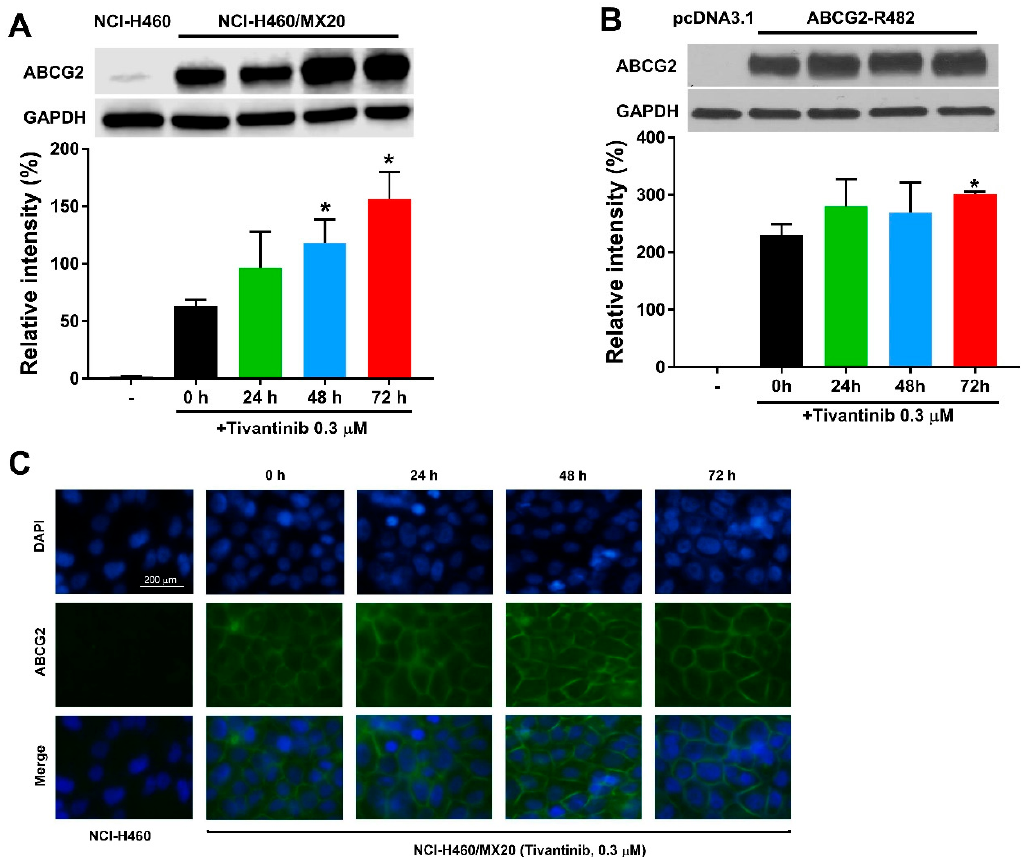
Figure 4. Tivantinib increases the protein expression in cells overexpressing ABCG2 without affecting the ability of ABCG2 to localize on the cell surface. ( A ) The effect of tivantinib on the protein expression of ABCG2 in NCI-H460/MX20 cells treated with 0.3 μ M of tivantinib for 0, 24, 48, and 72 h. ( B ) The effect of tivantinib on the protein expression of ABCG2 in HEK/293-ABCG2-WT cells treated with 0.3 μ M of tivantinib for 0, 24, 48, and 72 h. (C) Cell surface localization of ABCG2 expression in NCI-H460/MX20 cells incubated with 0.3 μ M of tivantinib for 0, 24, 48, and 72 h. Data are expressed as the mean ± SD from a representative of three independent experiments. * p < 0.05, compared with the control group. scale bar: 200 μ m